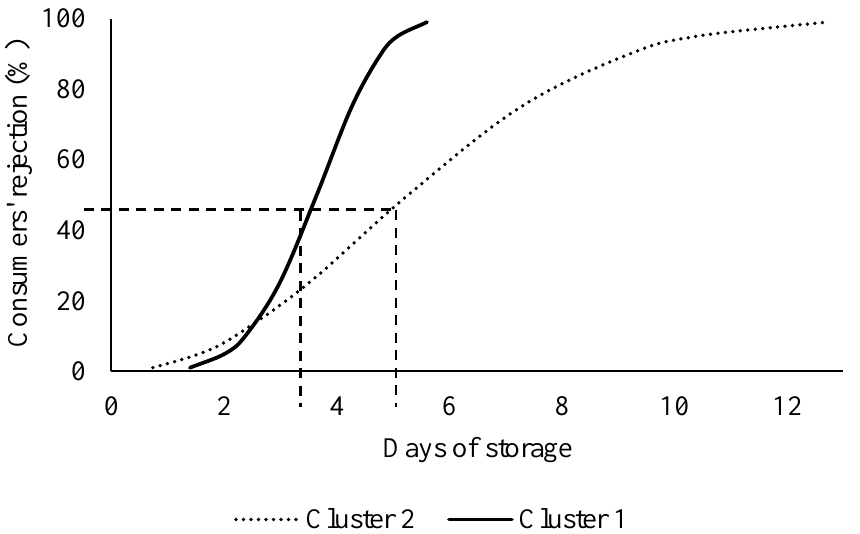
Figure 3. Probability of clusters 1 and 2 consumers’ rejection for the purchase of Nile tilapia (Oreochromis niloticus) fillets versus storage time at 4 ± 1 °C by Weibull distribution; 50% rejection points are indicated by the dashed line.